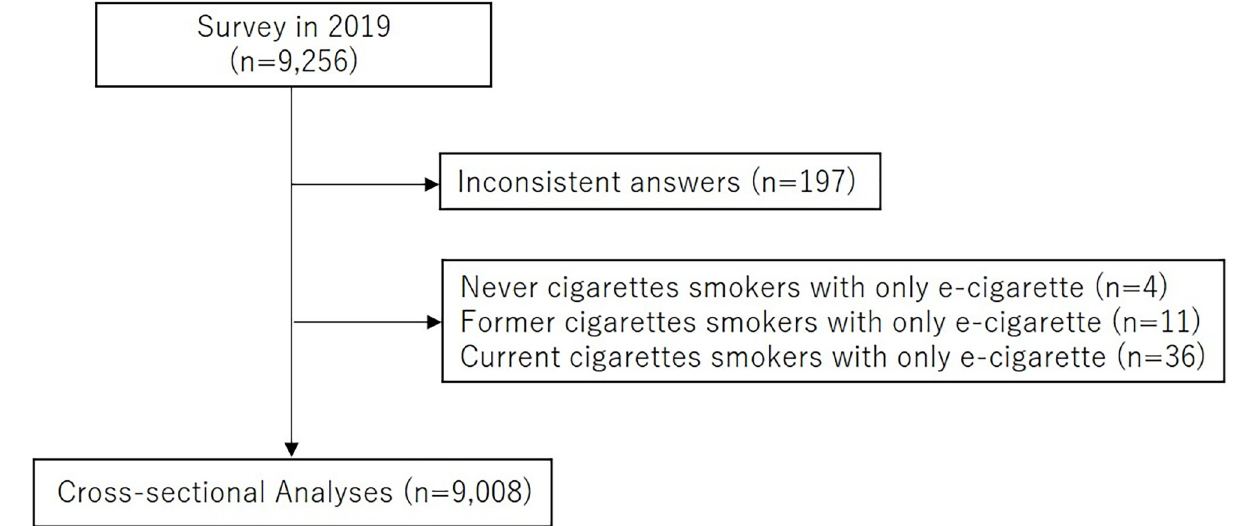
Fig 1. Flow diagram of study selection